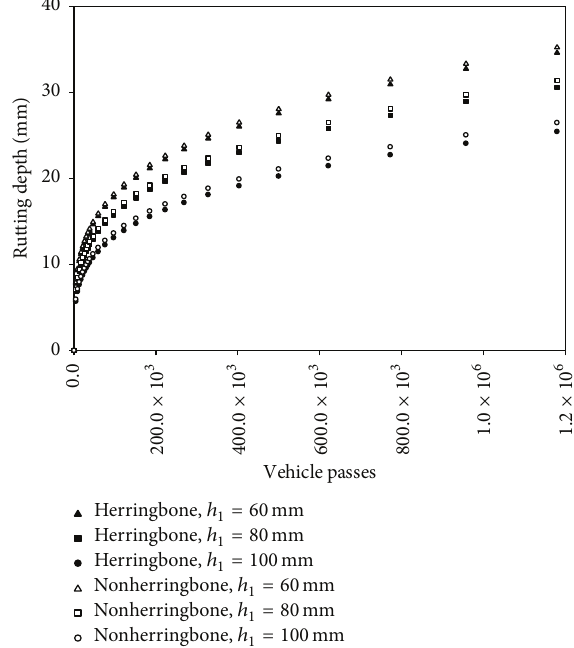
Figure 11: Difference in rut depth depending on block